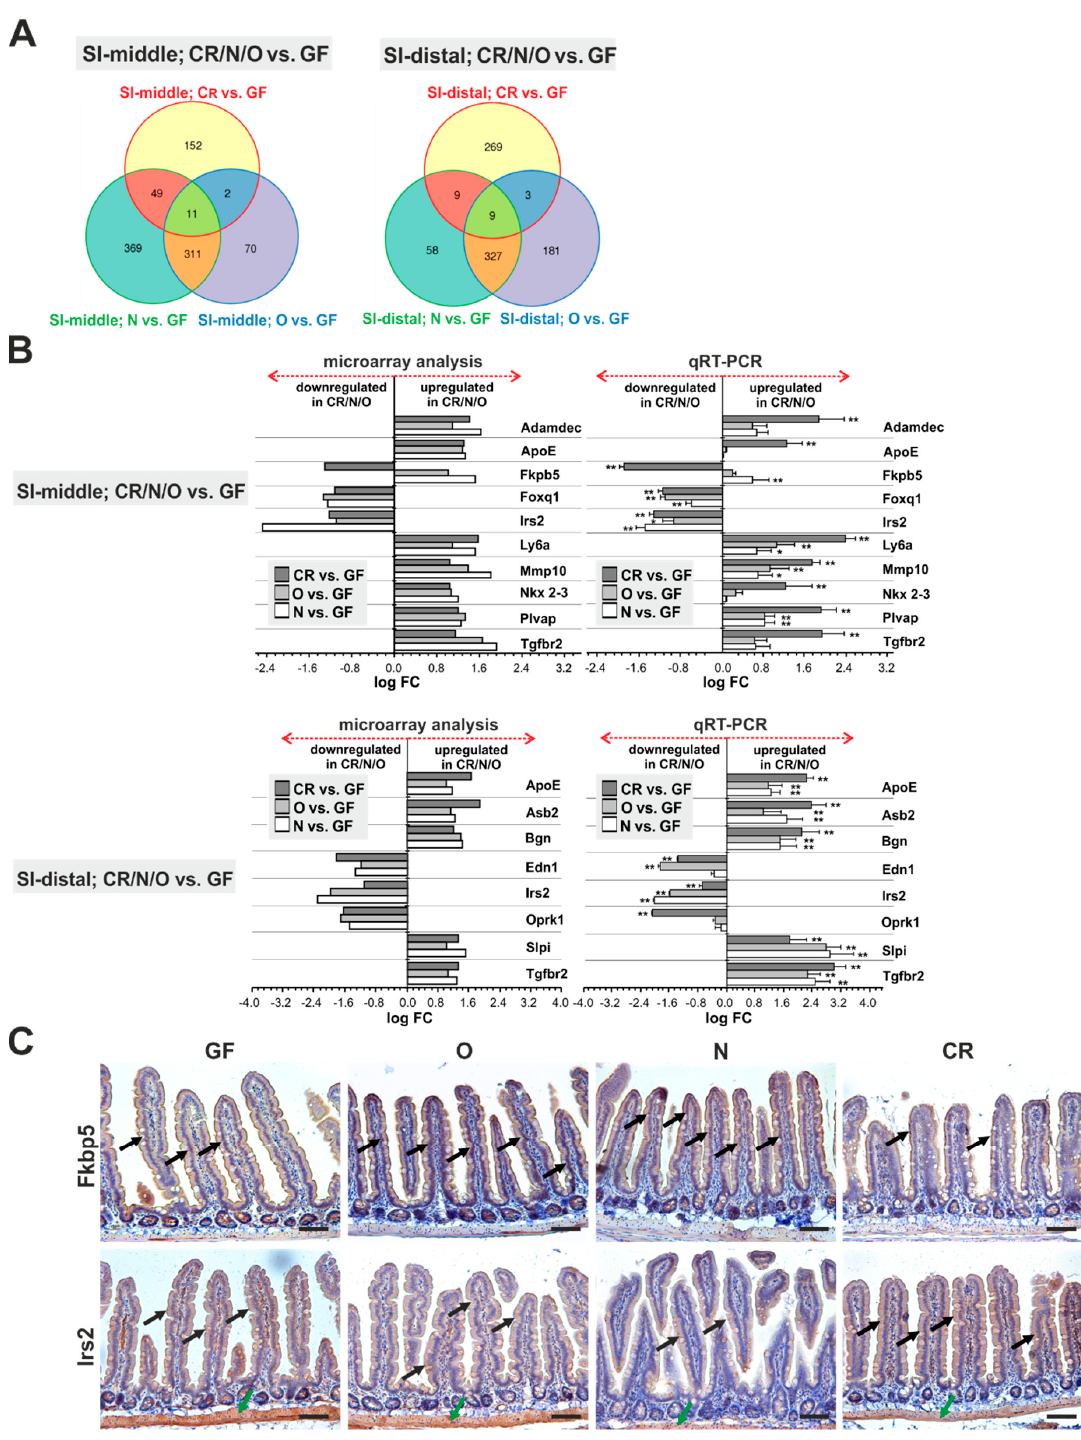
Figure 2. A limited number of genes are uniquely expressed in the GF small intestine. ( A ) Venn diagrams comparing gene expression profiles in small intestinal segments of CR, N, and O animals when contrasted with the gene expression profile obtained in GF mice. Eleven gene probes (representing 10 annotated genes) and 9 gene probes (representing 8 annotated genes) were differentially expressed in the SI-middle or SI-distal segment, respectively (selection criterion: |log FC| ≥ 1; p < 0.05 in at least two of three comparisons). The genes are listed in Supplementary Table S3. ( B ) Validation of cDNA microarray by qRT-PCR. Diagrams depict expression analysis of the indicated genes performed by cDNA microarray hybridization (left) or by qRT-PCR (right). Normalized fluorescence signal obtained in the respective gene probe upon hybridization with RNA isolated from GF mice was set to 1.